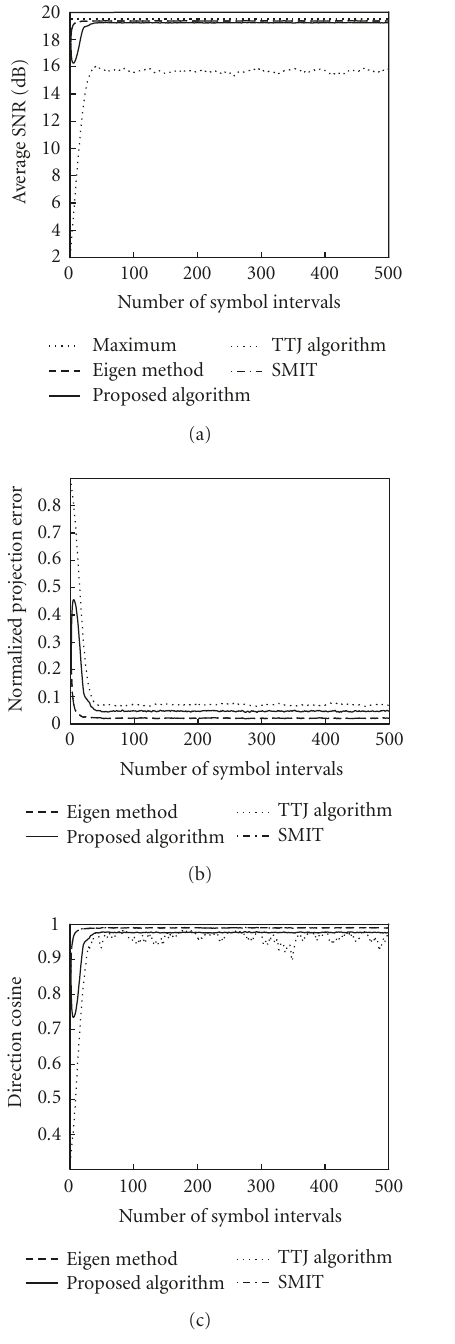
Figure 1: (a) SINR performance in the case of two interferers. (b) Normalized projection error in the case of two interferers. (c) Di- rection cosine performance in the case of two interferers.